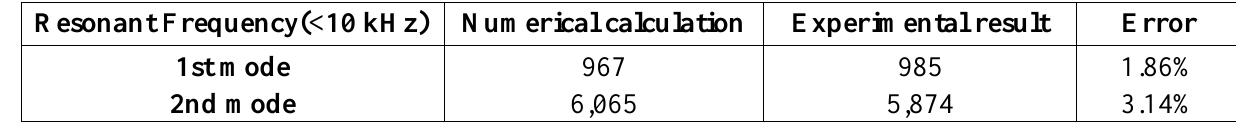
Table 2. Verification of numerical optimization.